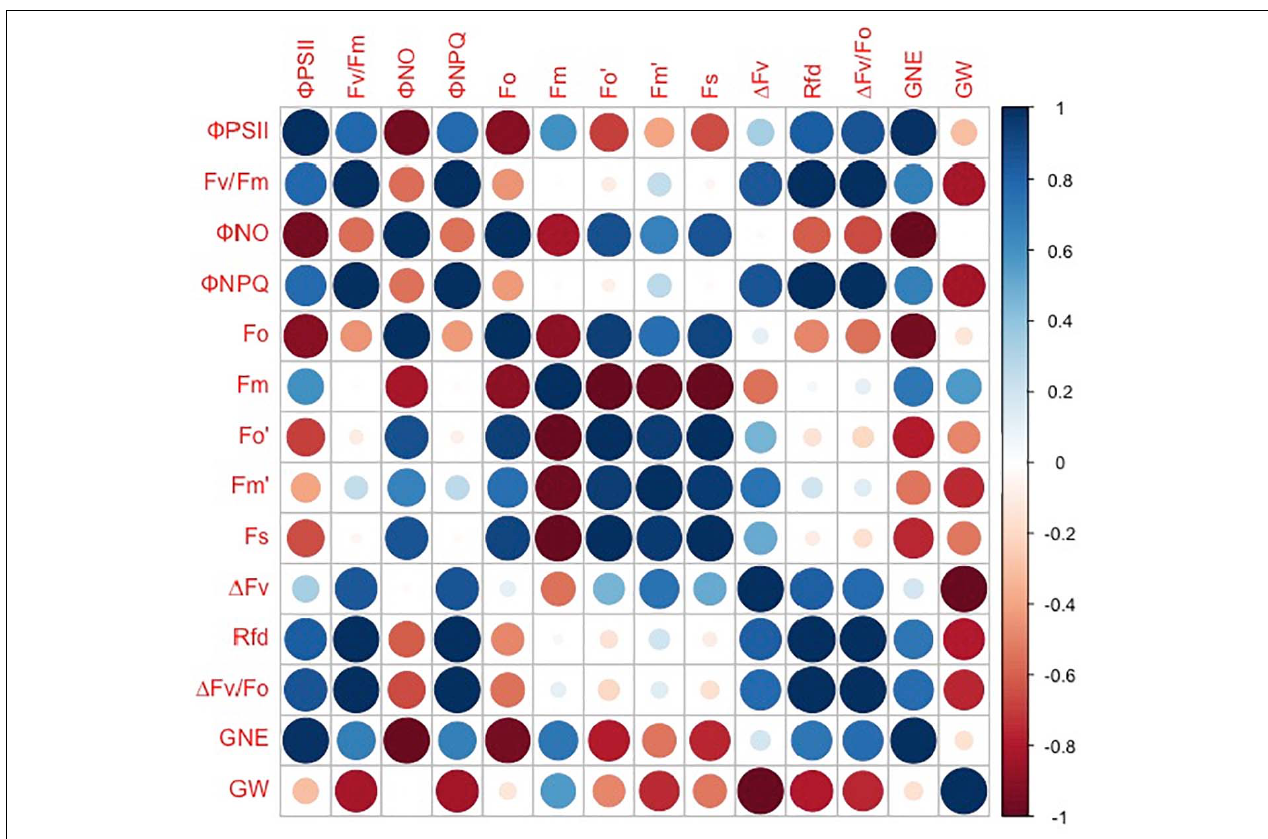
FIGURE 8 | Correlations between grain number per ear (GNE), 1,000-kernel weight (GW), (cid:56) PSII , Fv/Fm, (cid:56) NO , (cid:56) NPQ , Fo, Fm, Fo (cid:48) , Fm (cid:48) , Fs, (cid:49) Fv, Rfd, and (cid:49) Fv/Fo in ZYM. Spearman’s rank correlation coefficient-based correlograms of the measured parameters on plants grown under elevated CO 2 . The color of each square indicates the value of the correlation coefficient for each pair of traits following the color scale of the vertical color bar. The red and blue circles indicate negative or positive correlations between parameters,